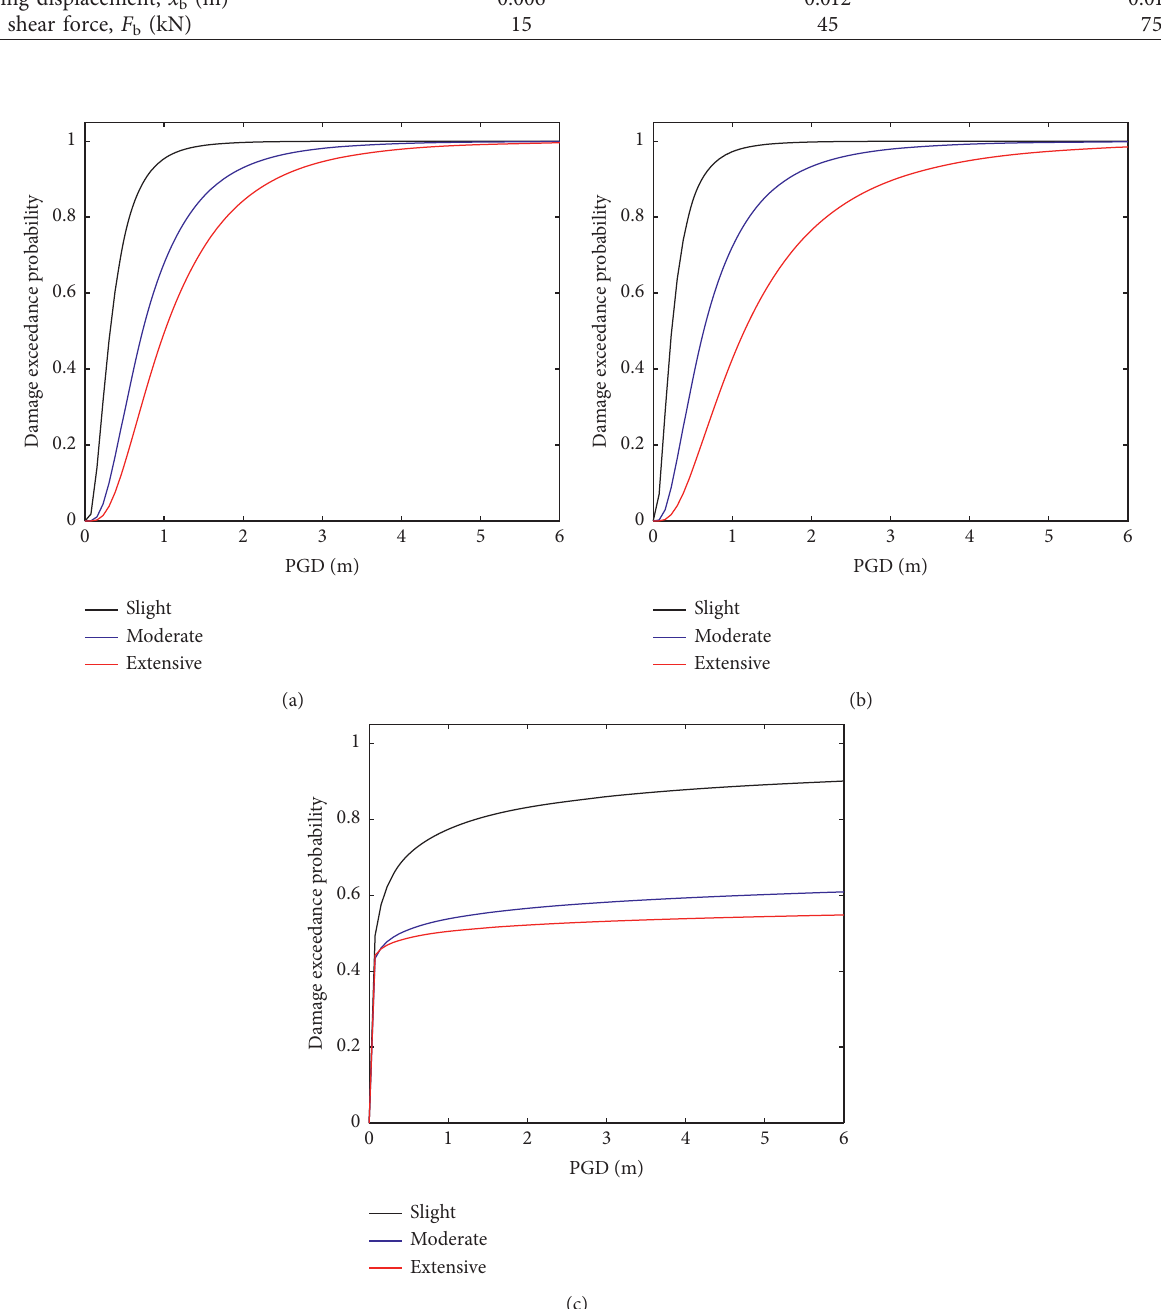
Figure 8: Seismic fragility curves: (a) convective displacement; (b) bearing displacement; (c) base shear